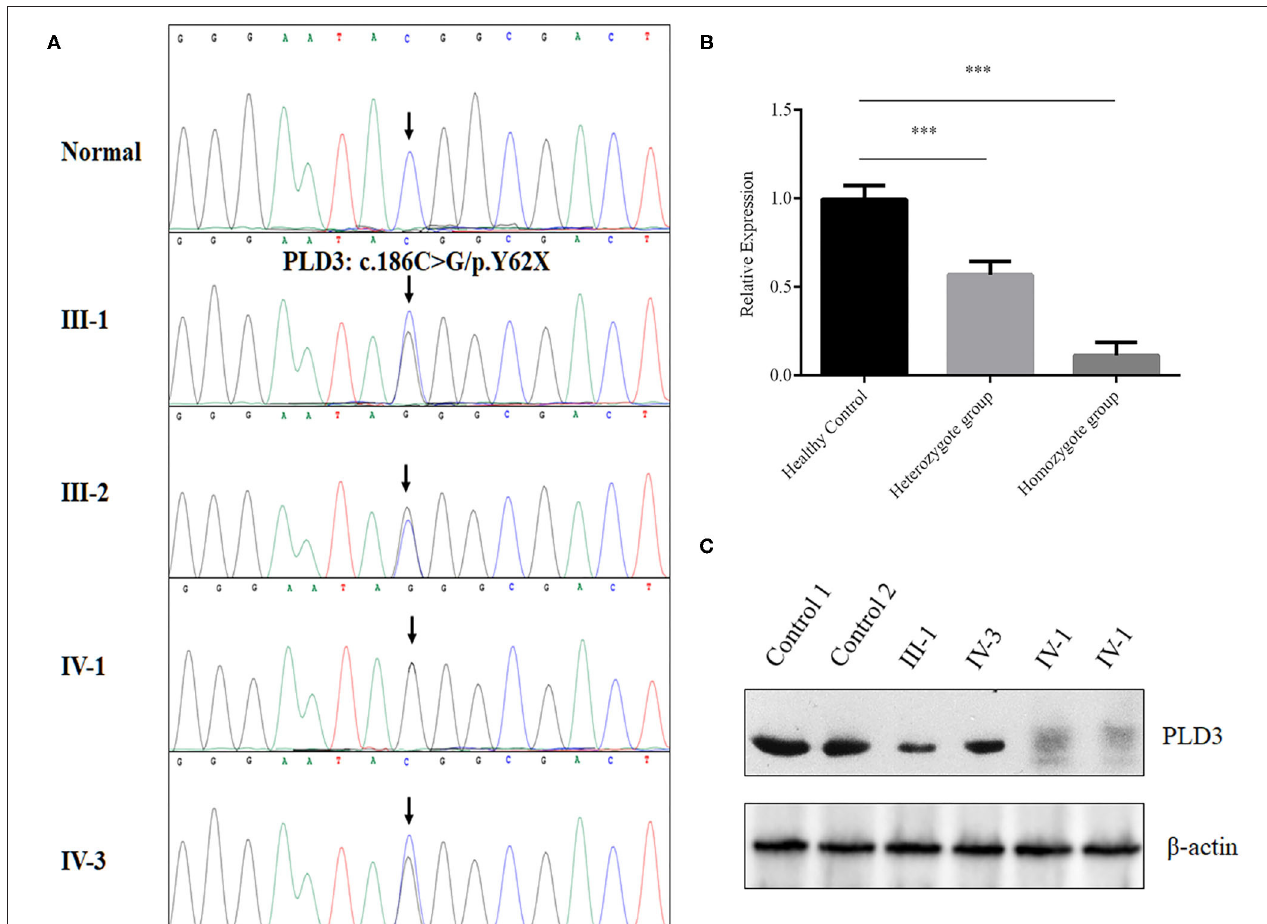
FIGURE 2 | Genetic analysis of the family. (A) Sanger sequencing analysis of the PLD3 gene in the patients, their family members, and the controls. (B) Real-time PCR determined the messenger RNA (mRNA) levels of phospholipase D3 (PLD3) in white blood cells from healthy controls (five samples), heterozygotes (III-1, III-2, and IV-3), and a homozygote (IV-1, repeated three times). *** p < 0.01. (C) Western blot analysis of the expression of PLD3 in white blood cells from healthy controls (two samples), the heterozygote group (III-1 and IV-3), and the homozygote group (IV-1, repeated two